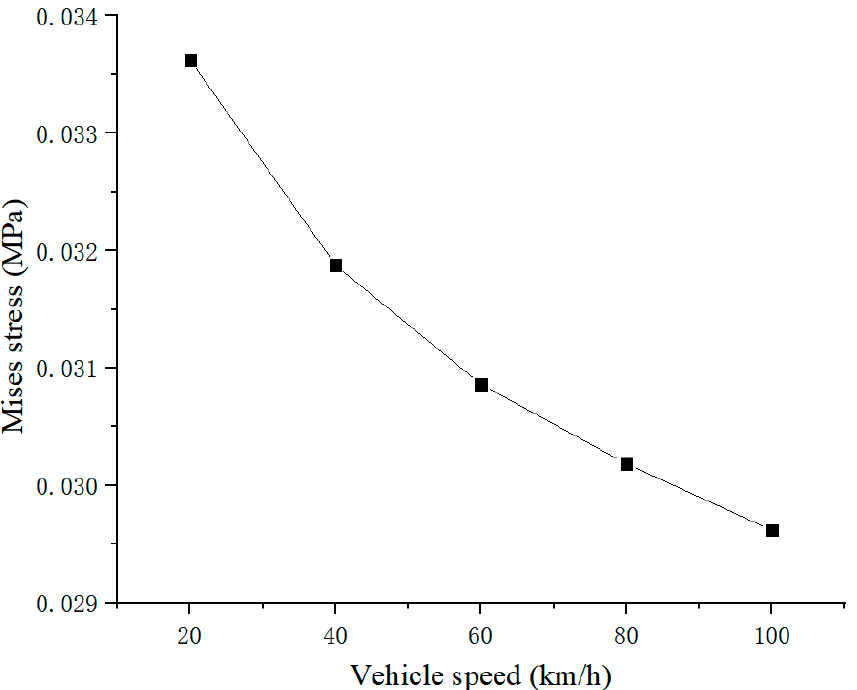
Figure 20. Variation of Mises stress of the wall at 14.625 m under different vehicle speeds.